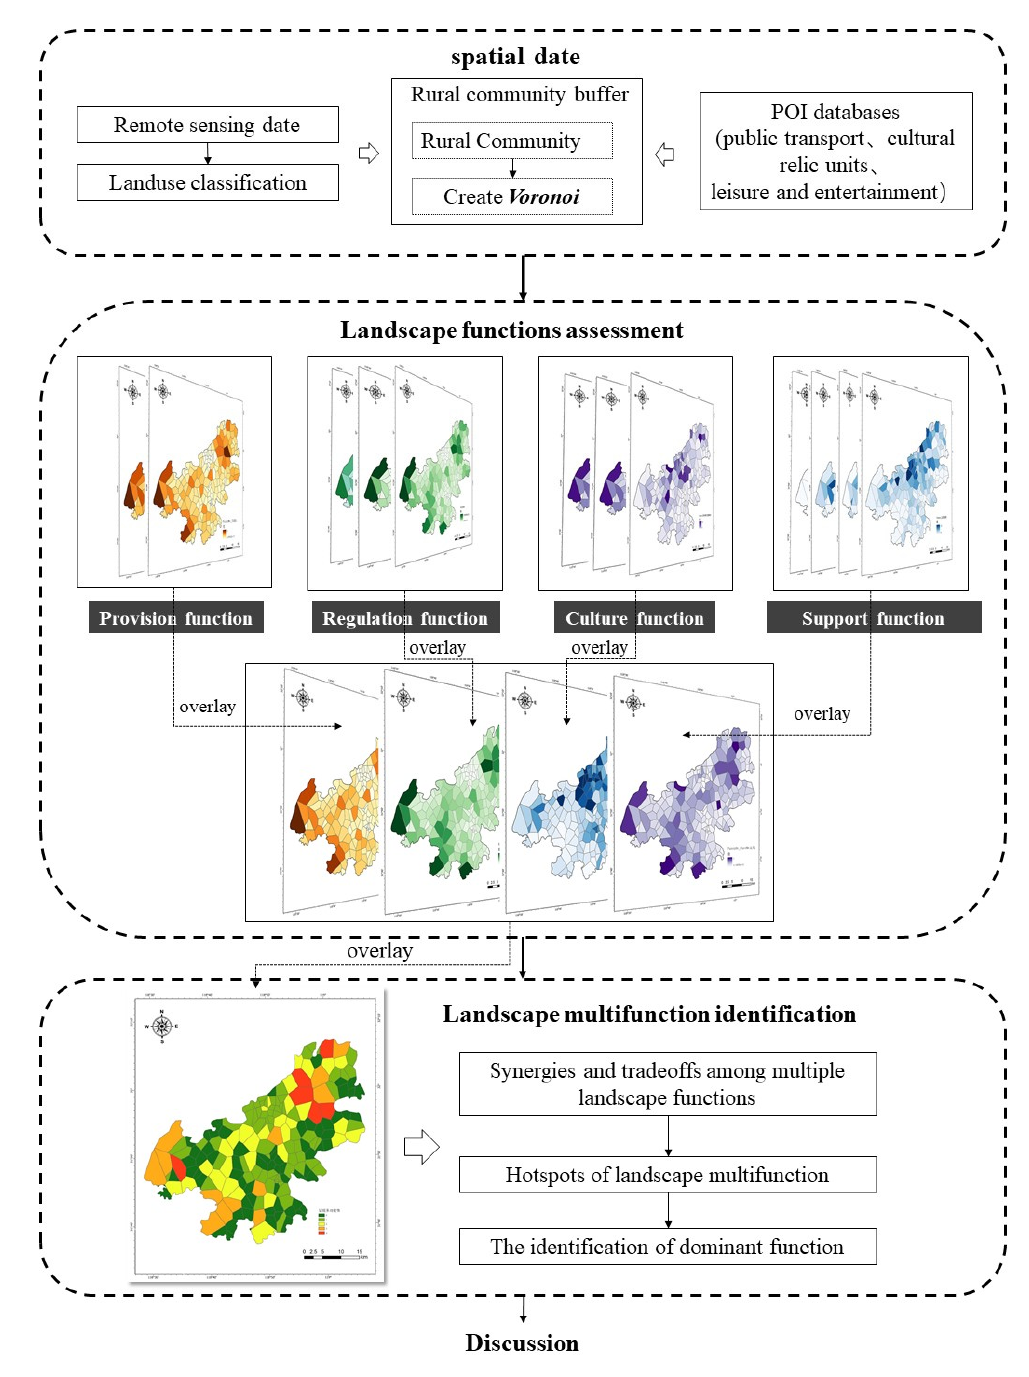
Figure 3. Analytical framework.